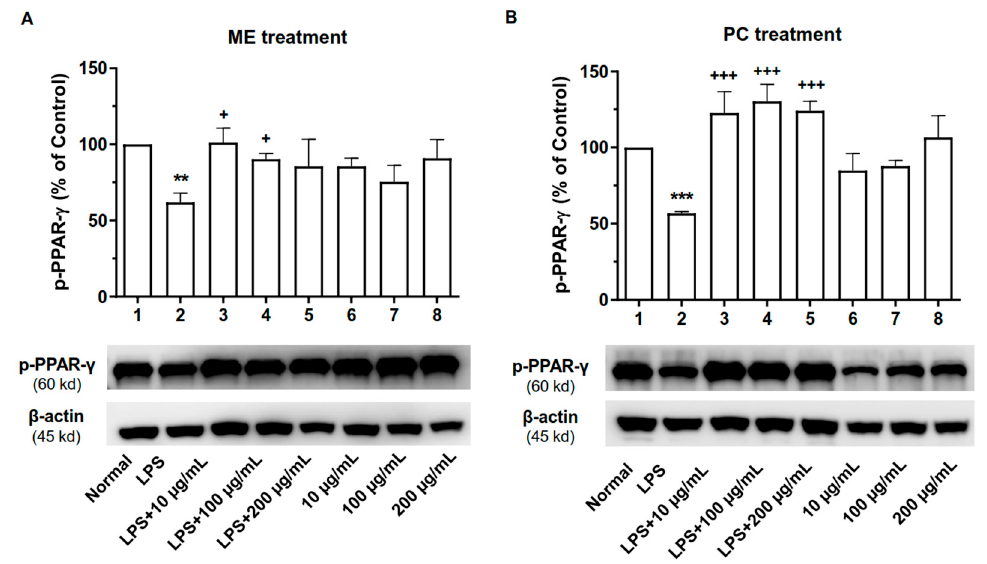
Figure 8. Effect of ME and PC on p-PPAR- γ protein in RAW 264.7 cells. The expression level of p-PPAR- γ protein was measured after ME ( A ) or PC ( B ) treatment in RAW 264.7 cells. 1—Normal group, 2—LPS-treated control group, 3—LPS- treated control group + 10 µ g/mL ME or PC, 4—LPS-treated control group + 100 µ g/mL ME or PC, 5—LPS-treated control group + 200 µ g/mL ME or PC, 6—Normal group + 10 µ g/mL ME or PC, 7—Normal group + 100 µ g/mL ME or PC, 8—Normal group + 200 µ g/mL ME or PC. β -Actin was used as an internal control. Values are mean ± SEM ( n = 3). These values are expressed as the percentage of the control tested protein/ β -actin for each sample. ME-treatment (B): 1 vs. 2 p = 0.0091, 2 vs. 3 p = 0.0296, 2 vs. 4 p = 0.0457; PC-treatment (C): 1 vs. 2 p = 0.0009, 2 vs. 3 p = 0.0008, 2 vs. 4 p = 0.0002, 2 vs. 5 p = 0.0004. (one-way ANOVA for multiple comparisons, ** p < 0.01, *** p < 0.001; + p < 0.05, +++ p < 0.001).